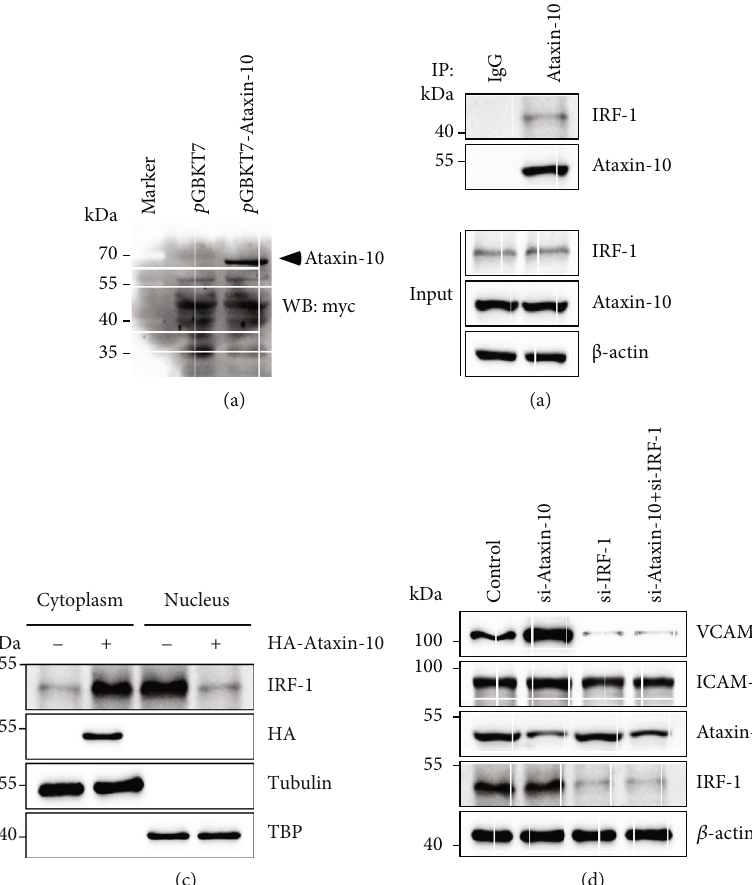
Figure 6: Ataxin-10 binds to and inhibits IRF-1 to suppress TNF- α -induced VCAM-1 in HUVECs. (a) Cell lysates were harvested from Y2HGold yeast strain transfected with pGBKT7 or pGBKT7-Ataxin-10. The expression of Ataxin-10 was detected by Western blotting. (b) HUVECs were treated with 10ng/mL TNF- α for 2 hours. Immunoprecipitation experiment was performed with Ataxin-10 antibody and IgG (control), showing speci fi c interaction between Ataxin-10 and IRF-1 in HUVECs. (c) Western blotting analysis of endogenous IRF-1 subcellular localization in HUVECs transfected with empty vector of HA-Ataxin-10. The purity and equal loading of cytoplasmic fractions and nuclear fractions were con fi rmed by tubulin and TBP, respectively. (d) HUVECs were transfected with Ataxin-10 siRNA or IRF-1 siRNA or both and then treated with TNF- α (10 ng/mL) for 8 hours. VCAM-1 and ICAM-1 protein levels were detected by Western